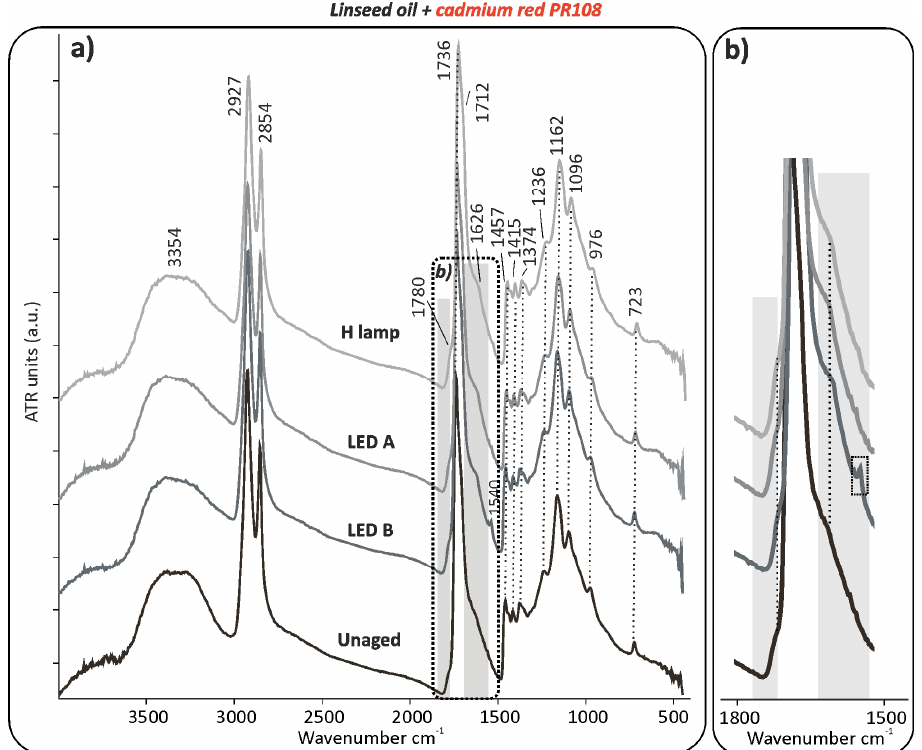
Figure 2. ( a ) µ-ATR-FTIR spectra of linseed oil with the cadmium red PR108 pigment before and after 5000 h of light ageing (LED A: 420 nm, LED B: 460 nm, and H lamp: halogen lamp). The highlighted regions show the broadening of the carbonyl peak at 1736 cm − 1 after ageing, which can be observed in detail in ( b ).